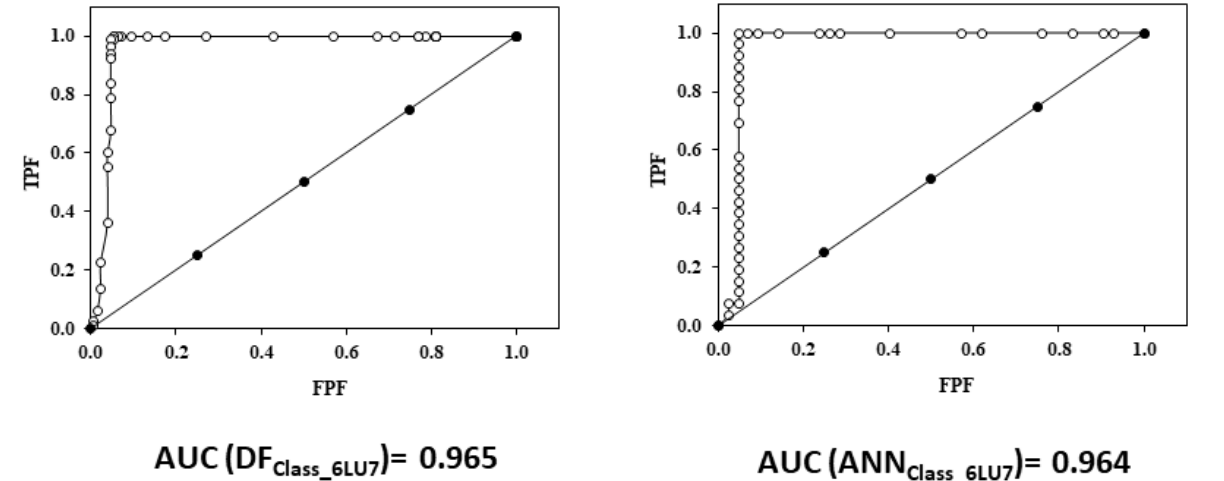
Figure 5. ROC curve for DF Class_6LU7 and ANN Class_6LU7. TPF: true positive fraction; FPF: false positive fraction.